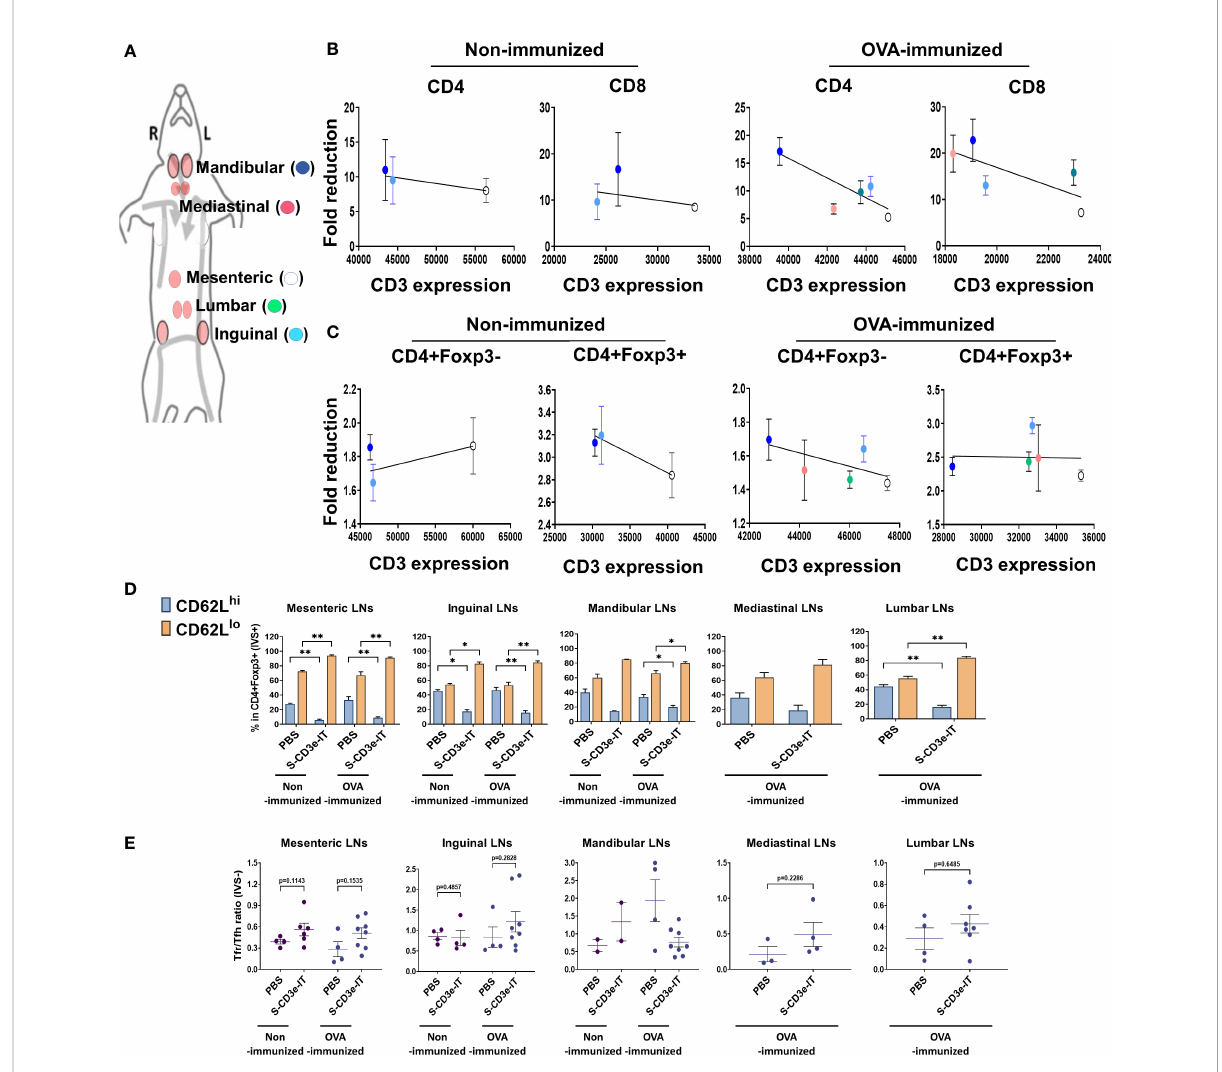
FIGURE 5 Consistent LN-to-LN variations. (A) Symbols of mesenteric (white), inguinal (light blue), mandibular (blue), mediastinal (red), and lumber (green) LNs are shown. (B) Fold reductions of CD4+ or CD8+ T cells (y-axis; S-CD3e-IT/PBS) and CD3e MFI of these cells in each LNs (x-axis) are shown. There was no positive correlation between CD3e MFI and CD4+ and CD8+ cell depletion rates. (C) Fold reductions of CD4+Foxp3- or CD4+Foxp3+ T cells (y-axis; S-CD3e-IT/PBS) and CD3e MFI of these cells in each LNs (x-axis) are shown. There was no positive correlation between CD3e MFI and CD4+Foxp3- cells. (D) CD62L lo and CD62L hi (% in CD4+Foxp3+ cells) are shown for these LNs. The surviving cells were enriched in CD4+Foxp3+ cell pools with the CD62L lo phenotype. (E) The Tfr-to-Tfh ratios (% in CD4+) are shown for these LNs. S-CD3e-IT- treated mice show higher Tfr-to-Tfh ratios in most of these LNs. Nonimmunized mice were treated with PBS ( n = 2~4, depending on LN types) or S-CD3e-IT ( n = 2~6). OVA-immunized mice were treated with PBS ( n = 3~4) or S-CD3e-IT) ( n = 4~8) * p < 0.05 and ** p <